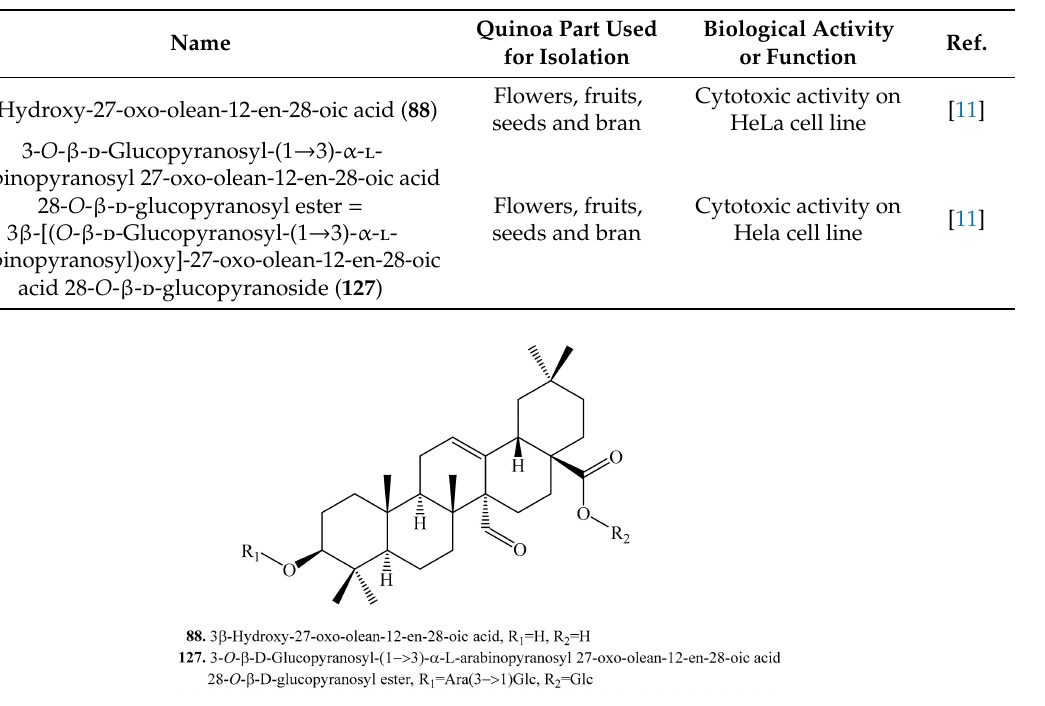
Table 15. 3 β -Hydroxy-27-oxo-olean-12-en-28-oic acid derivatives and their biological activities or functions.